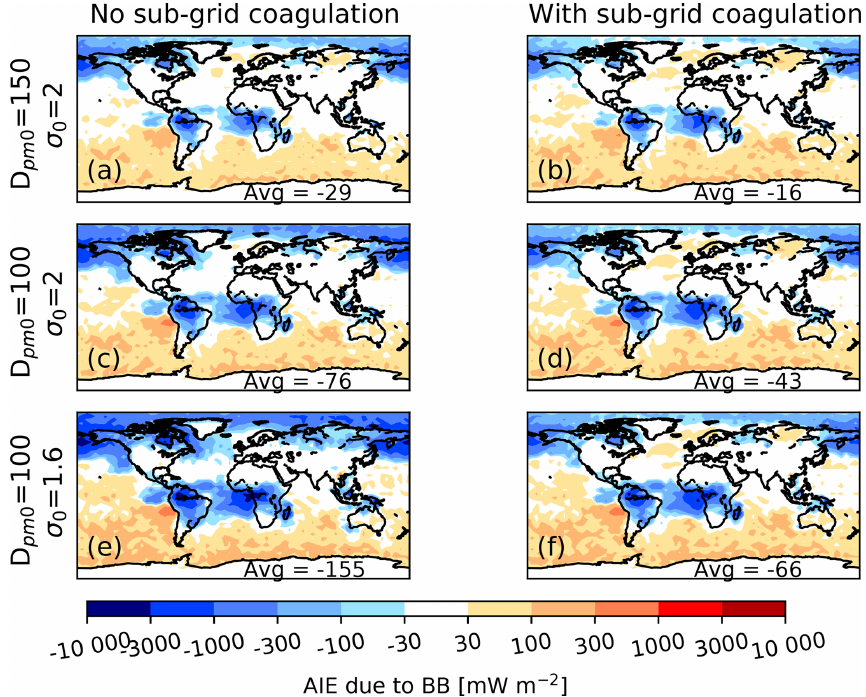
Figure 9. Cloud-albedo aerosol indirect effect (AIE) due to biomass burning aerosols using GFED emissions. Panels (a) , (c) , and (e) are without sub-grid coagulation ( D150_noSubCoag , noSubCoag , and s1.6_noSubCoag , respectively). Panels (b) , (d) , and (f) are with sub-grid coagulation ( D150_SubCoag , SubCoag , and s1.6_SubCoag , respectively). Panels (a) and (b) have an emitted median diameter of 150nm and an emitted modal width of 2. Panels (c) and (d) have an emitted median diameter of 100nm and an emitted modal width of 2. Panels (e) and (f) have an emitted median diameter of 100nm and an emitted modal width of 1.6. The number in the bottom right of each panel is the global mean AIE value (mWm − 2